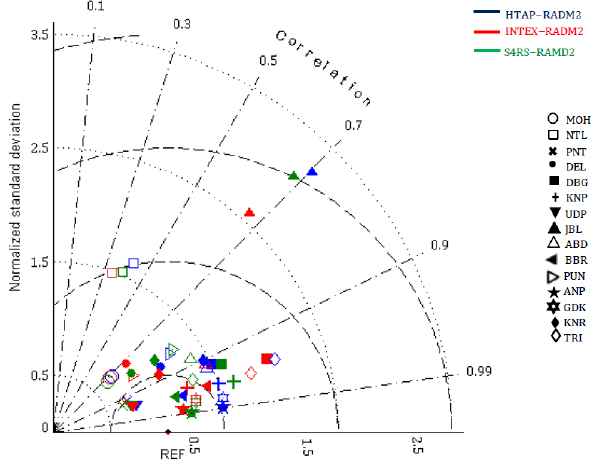
Figure 7. Taylor diagram with summary model statistics ( r , nor- malized SD and RMSD) at all sites. The correlation is the cosine of the angle from the horizontal axis, the root mean square difference is the distance from the reference point (REF) and the SD is the distance from the